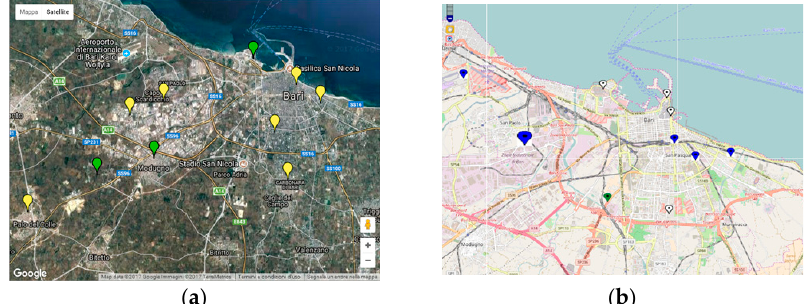
Figure 1. Map of: ( a ) air quality monitoring stations (10 units) managed by ARPA-Puglia, environmental protection local authority, in the Bari city; ( b ) wireless sensors network based on 10 low-cost stationary nodes deployed for urban air quality monitoring and operated by ENEA.